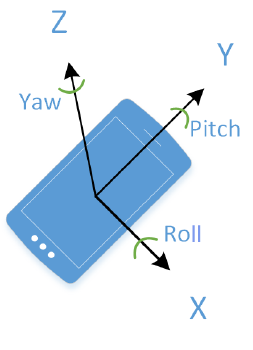
Figure 3. Axes of Android